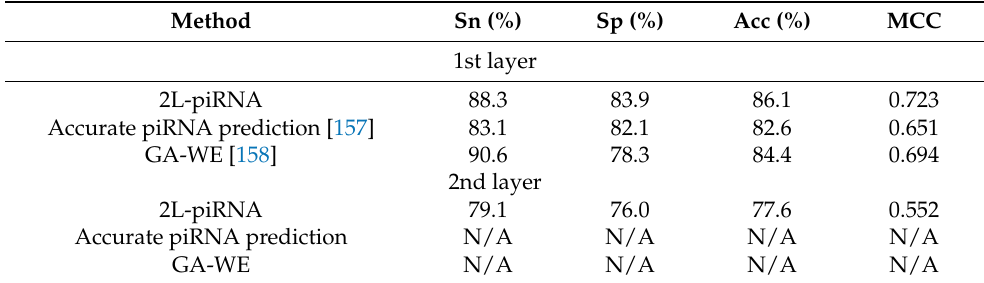
Table 3. 2L-piRNA outperforms the previously published methods across all the metrics used.